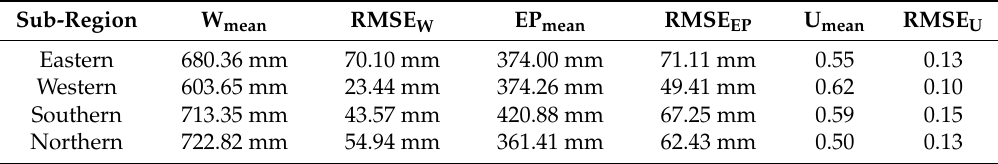
Table 4. The statistics of water balance and water suitability (1990~2013).